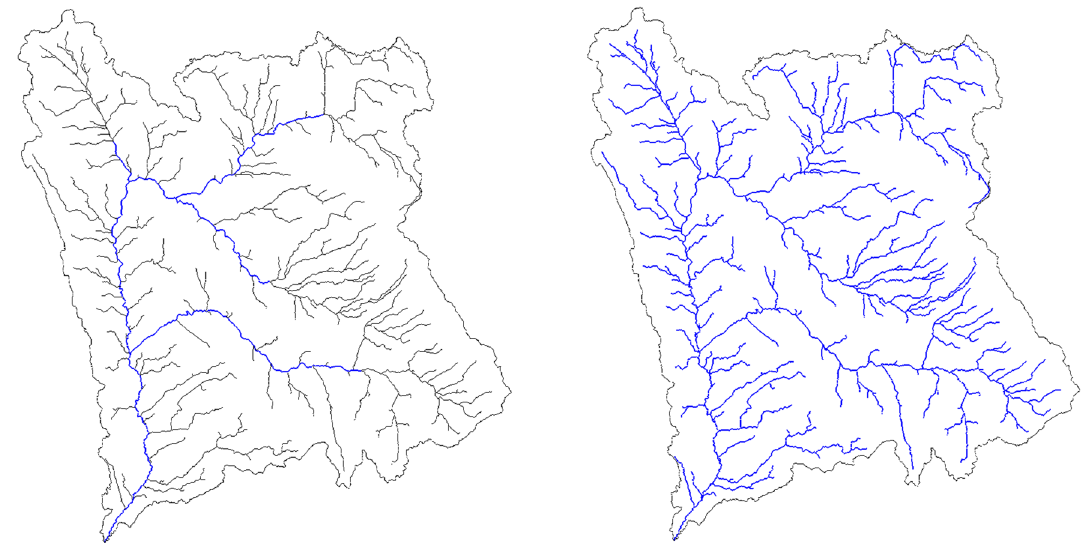
Fig. 3 GSSHA distributed model in two states of modeling main Karvandar River and major tributaries only (left) and modeling of all streams with drainage area greater than 5 km 2